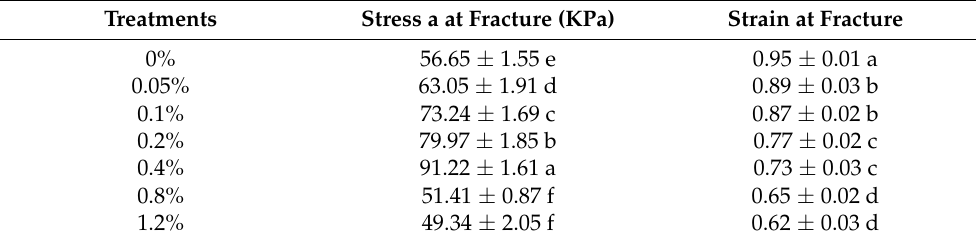
Table 1. The stress and strain at fracture of the MP composite gels with various CG.